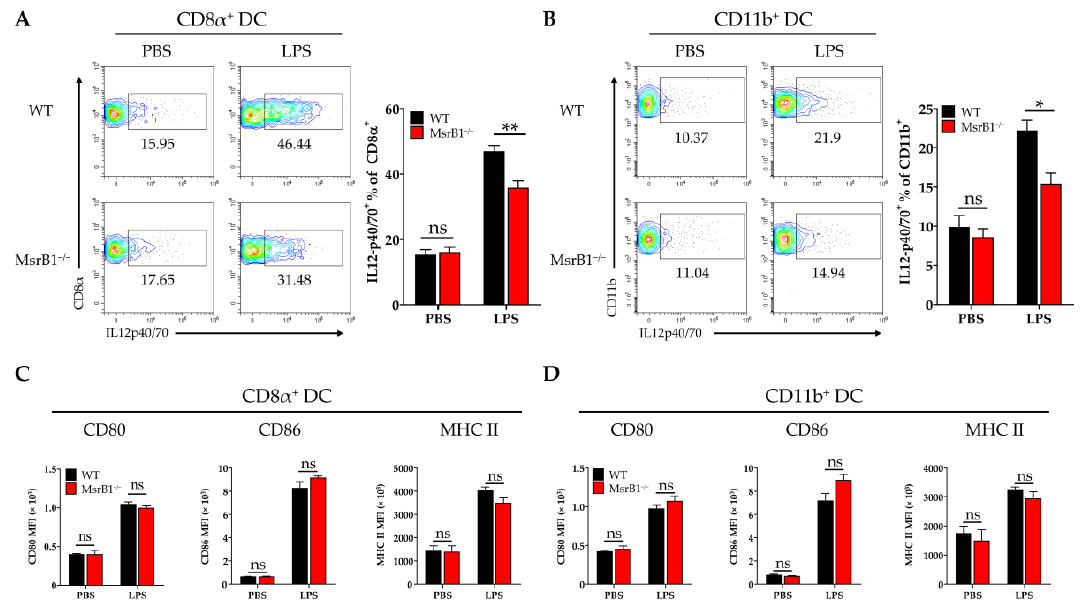
Figure 5. MsrB1 promotes the LPS-induced IL-12 production of classical splenic DCs in vivo. ( A – D ). Splenocytes isolated from WT and MsrB1 −/− mice 3 h after LPS injection were cultured in the presence of Brefeldin A for 4 h. The CD8α + ( A , C ) and CD11b + ( B , D ) DCs of the WT and MsrB1 −/− mice ( n = 6 per group) were analyzed by flow cytometry for their intracellular IL-12 p40/70 levels ( A , C ) and their expression of CD80, CD86, and MHC II ( B , D ). The classical DCs were analyzed by gating on the CD8α + or CD11b + cells in the live CD11c + MHC II + cells. Mean ± SEM are shown. * p < 0.05, ** p < 0.01;